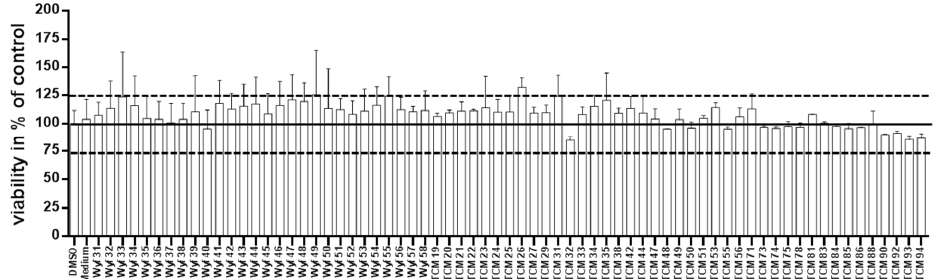
Figure 1. Toxicity assay of tested substances. SH-SY5Y cells were incubated for 48 h with 0.1% vol/vol substance and viability was assessed using the Cell Titer Glo assay. DMSO (solvent) and pure culture medium served as controls. Values ± SD were collected from at least two independent experiments.